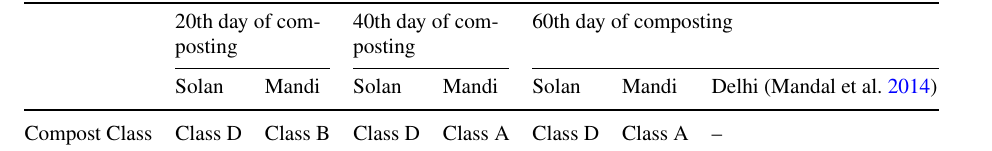
‘Fertility Index’ and ‘Clean Index’ of compost material of study regions with compost of Okhla plant, Delhi